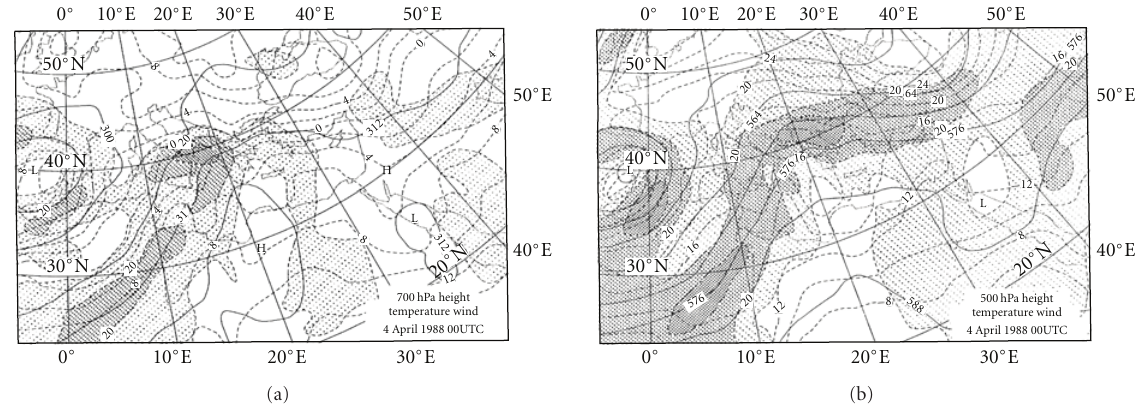
Figure 14: Same as Figures 3(b) and 3(c), but for 00:00 UTC on 4 April 1988, (a) 700 hpa and (b) 500hpa.